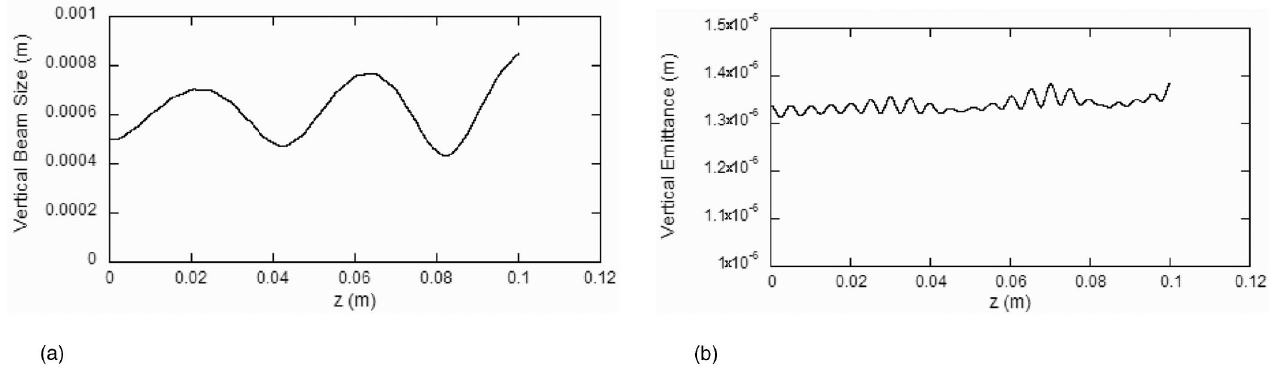
FIG. 5. (a) 4-times y beam size versus axial distance for a 70% wiggler, 30% PPM field split. (b) Normalized vertical emittance rms versus axial